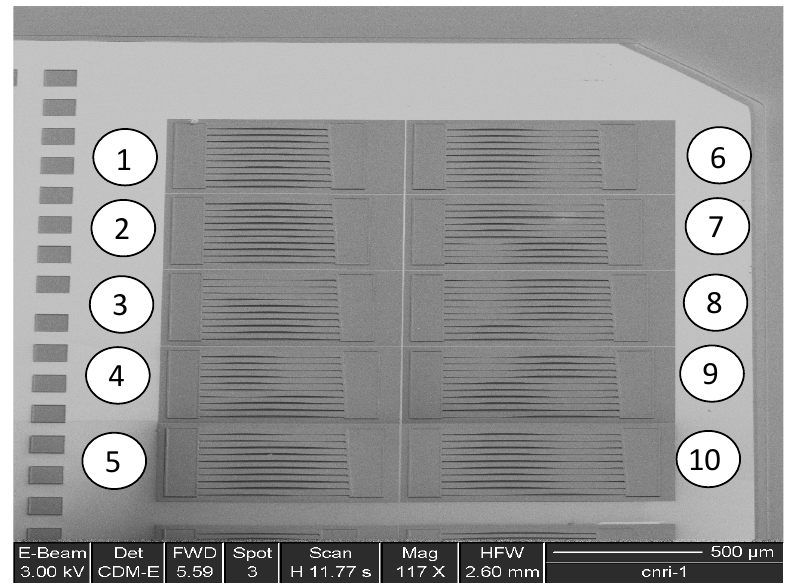
Figure 7. SEM image of an array of fixed-fixed beam test structures used to determine the compressive residual stress in thin-film layers [3].